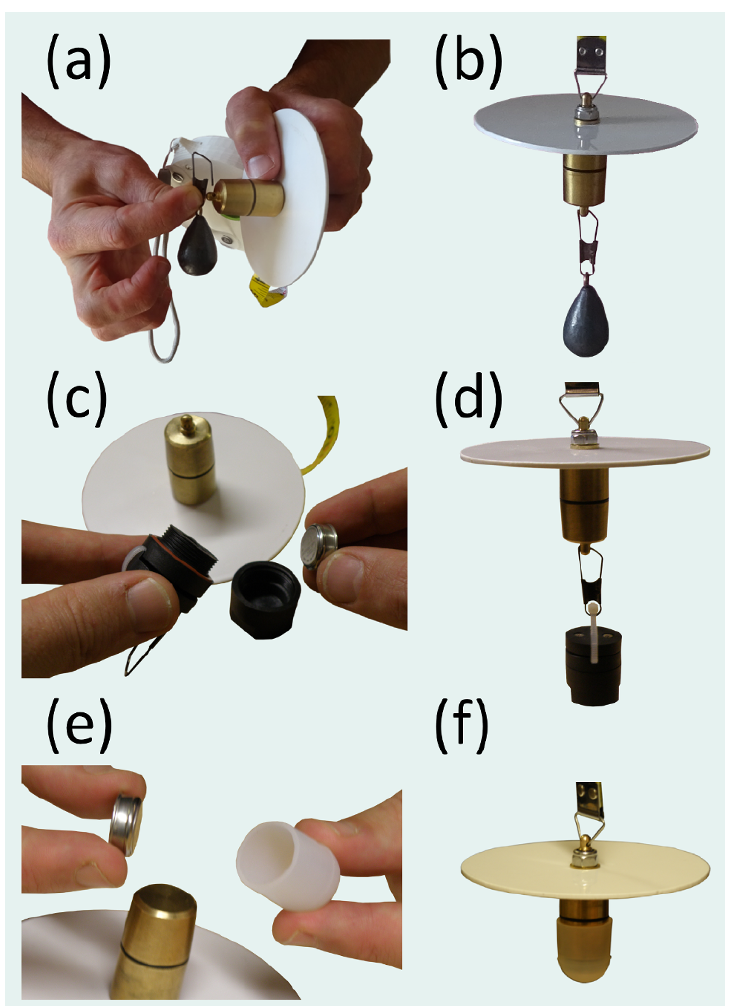
Figure 6. Additional weight and sensors can be added to the mini-Secchi disk. ( a – b ) Shows how additional weight (a standard fishing weight) can be attached to one of the weight designs of the mini-Secchi disk for operation in currents, or in cases where the platform may be moving (e.g., from a boat). ( c – d ) An iButton housed in a Thermochron waterproof capsule (DS9107) is attached to one